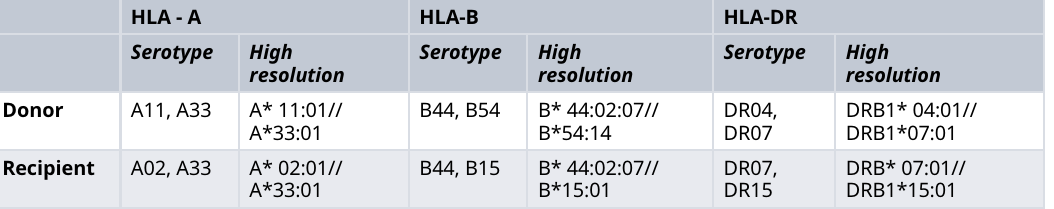
Table 1. HLA-ABDR typing (donor-recipient) examination results with PCR-SSP method. PCR-SSP: polymerase chain reaction-based sequence specific primers; HLA: human leukocyte antigen; ABDR: AB serology and oligotyping for